Question: Provide a one-line summary of what is displayed.
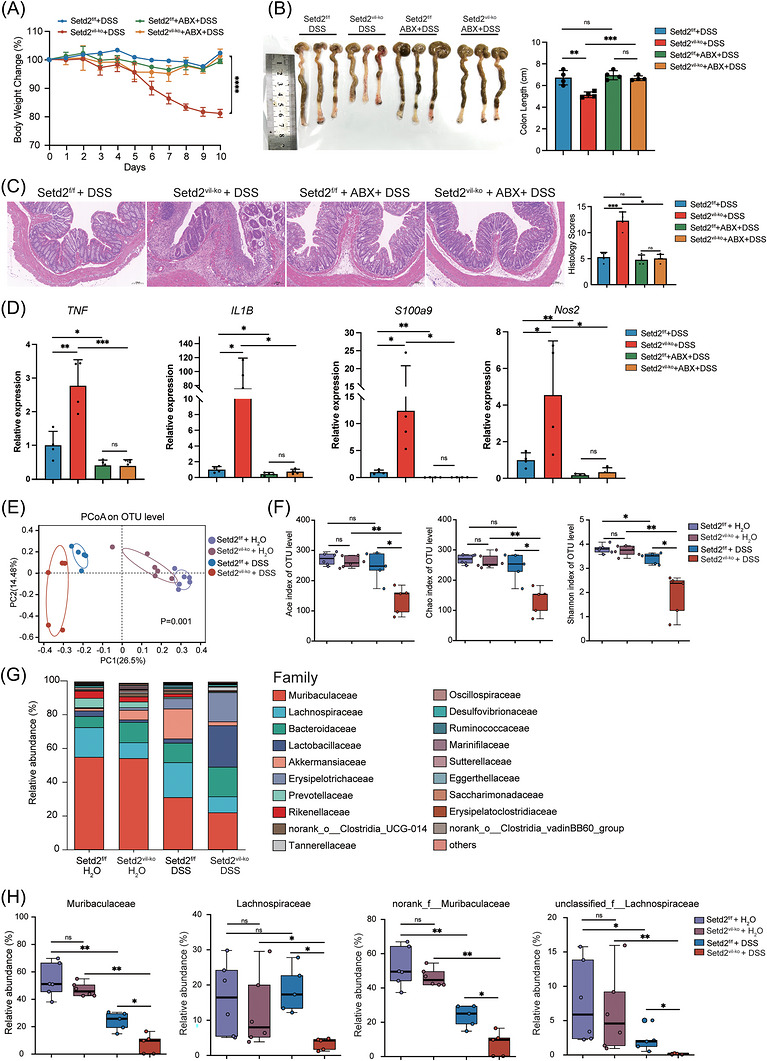
Answer: Gut microbiota dysbiosis is indispensable for SET domain containing 2 (SETD2) deficiency‐induced colitis exacerbation. (A) Daily body weight changes in mice. n = 4 mice per group. (B) Representative images of colon shortening and statistical analysis. (C) Haematoxylin and eosin (H&E) staining of colon tissues collected on day 10 and corresponding quantification of histology scores. (D) Relative mRNA expression levels of TNFα , IL1β , S100a9 and Nos2 determined by real‐time qPCR in antibiotics (ABX)‐treated or untreated Setd2 f/f and Setd2 vil‐ko mice. (E) Principal coordinates analysis (PCoA) atlas of the faecal microbial communities. (F) Alpha diversity analysis shown by the Ace index, Chao index and Shannon index. (G) Relative abundance of faecal microbial communities at the family level in water‐ and DSS‐treated Setd2 f/f and Setd2 vil‐ko mice. (H) Relative abundance of indicated gut microbiota in water‐ and DSS‐treated Setd2 f/f and Setd2 vil‐ko mice. All the data are presented as mean ± standard deviation (SD). For body weight curve, p ‐values were calculated between ABX‐untreated and untreated Setd2 vil‐ko mice at day 10. p ‐Values for 16s rRNA‐seq were calculated using Mann‒Whitney U test. p ‐Values for others were calculated using two‐tailed Student's t ‐test. * p < .05; ** p < .01; *** p < .001; **** p < .0001.